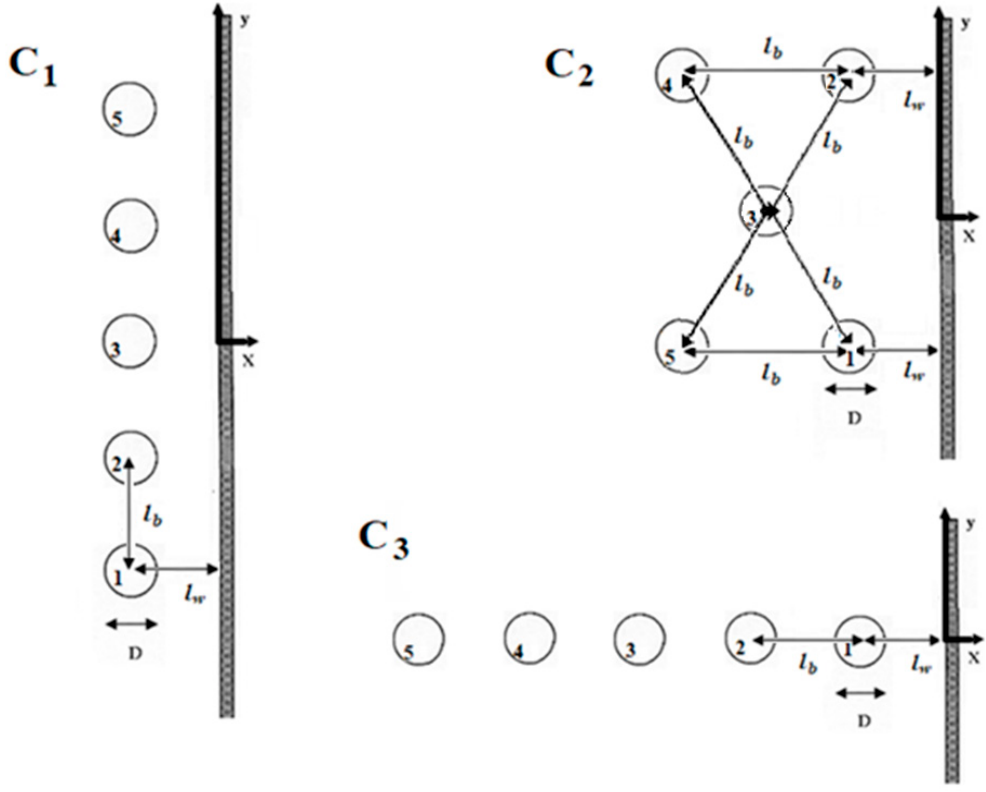
Figure 6. Three different examined array configurations concerning the position of each floater to the incoming wave and the vertical breakwater. The array C 1 is placed in a parallel direction to the wall; the array C 2 in a rectangular arrangement in front of the wall; and the array C 3 is placed in a perpendicular direction to the wall.